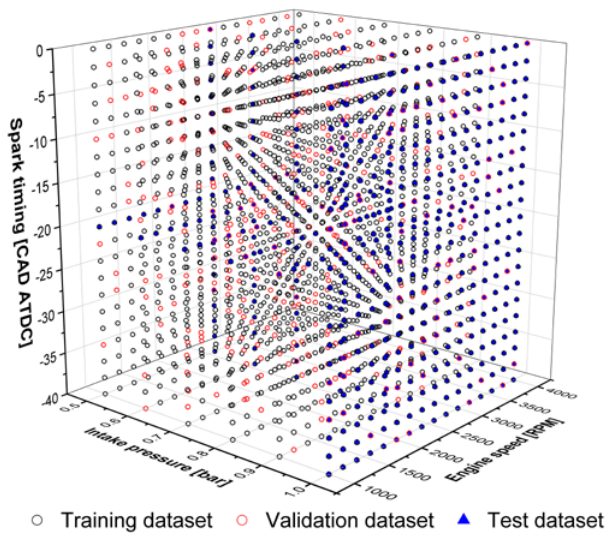
Figure 5. Partition of data sets in this paper.